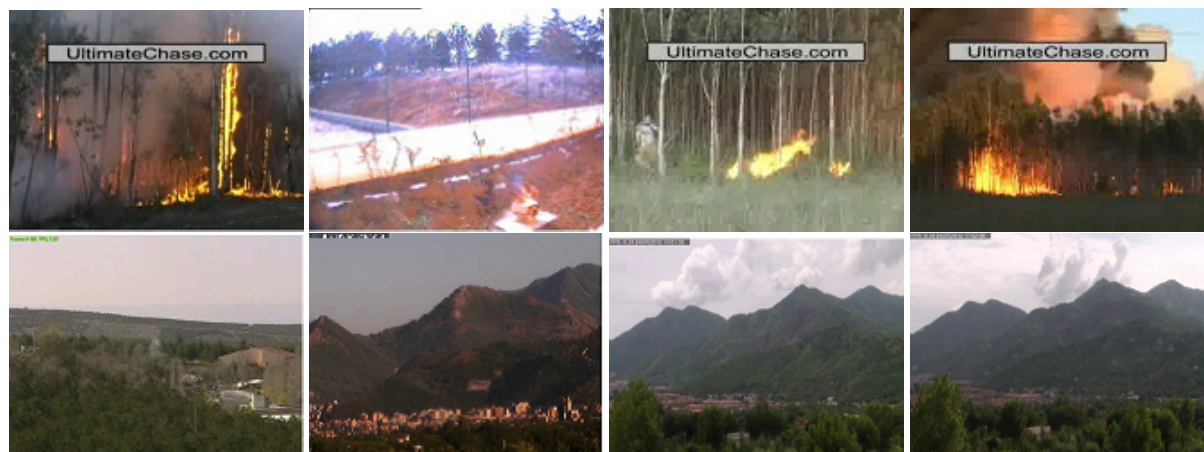
Figure 13. Examples from the MIVIA dataset. ( Top ): Fire images; ( Bottom ) line: non-fire